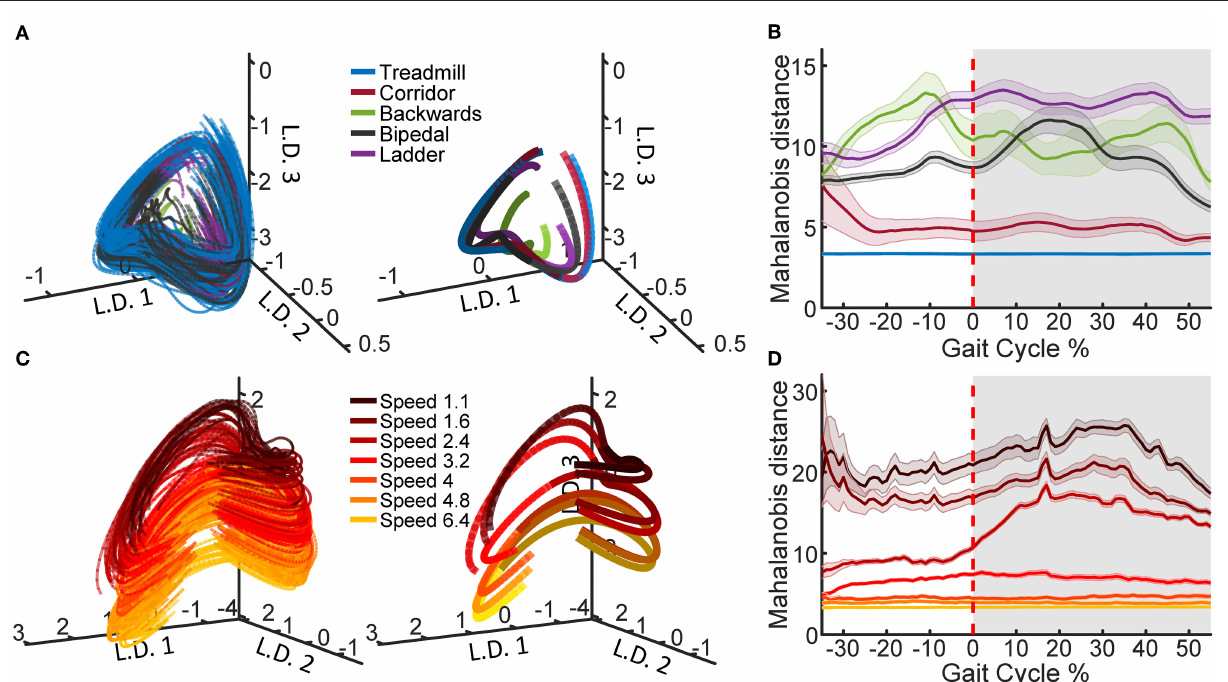
FIGURE 2 | Latent state space of neural population activity during locomotion. (A) Neural trajectories obtained from the PLDS model for the gait cycles of all tasks in animal Q1 on recording day 1. The trajectories in the first three latent dimensions (L.D.) for each individual gait cycle are shown (left), as well as task-averaged trajectories over the total gait cycle (right). (B) The Mahalanobis distance between the trajectories of each of the tasks and the trajectories of the treadmill task, calculated on all 12 dimensions. Shaded region denotes stance phase (0–60% of the gait cycle), shaded bars denote 1 S.E.M. (C) PLDS state-space trajectories in 3 dimensions for all treadmill walking trials at different locomotion speeds in animal Q2, session 2. Darker colors represent slower speeds; all speed values displayed in the legend are in km/h. As in (A) , individual gait cycles (left) and gait cycles averaged for each speed (right) are shown. For the average trajectories in both (A,C) , the darker shade represents the stance phase while the lighter shade represents the swing phase. (D) The Mahalanobis distance between the trajectories of each of the speeds and the trajectory of the fastest speed (6.4